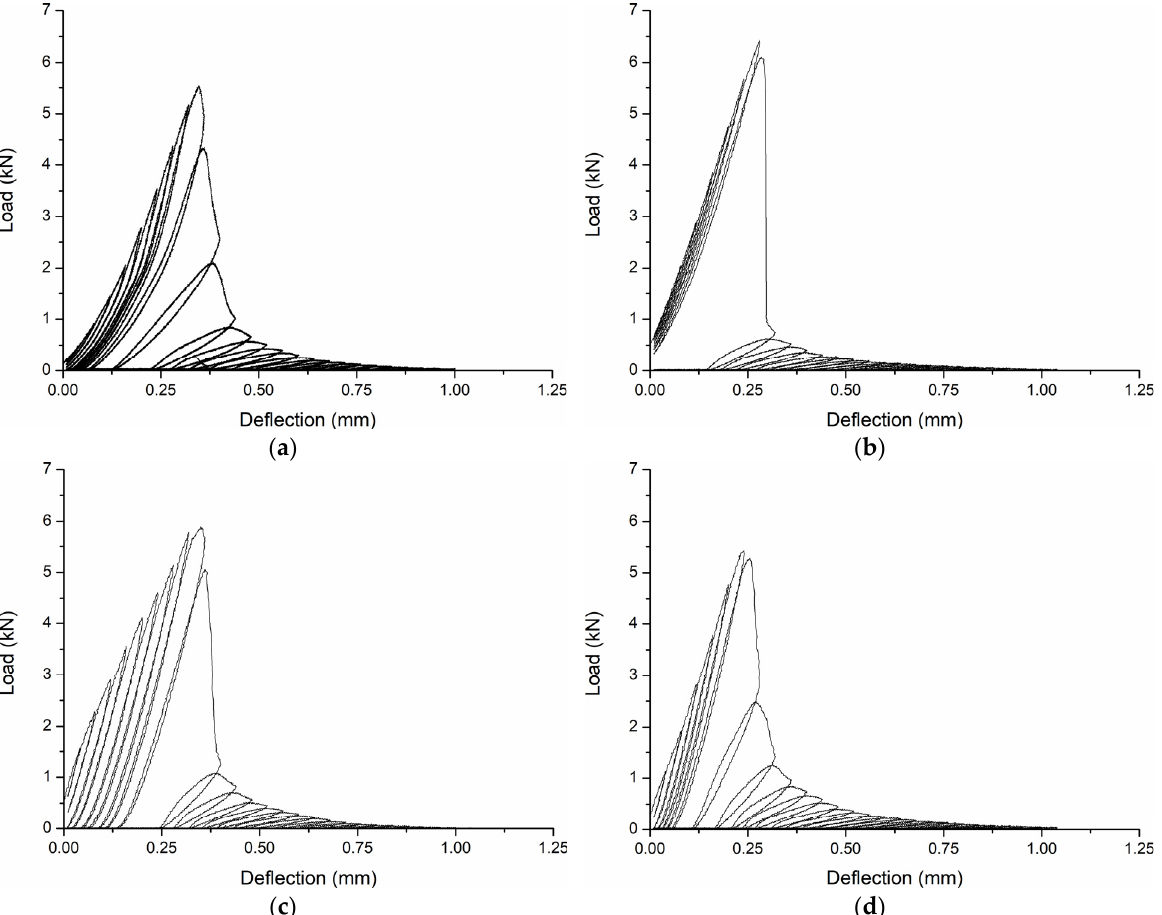
Figure 6. Geometry of notched beam specimens under center-point loading arrangement.